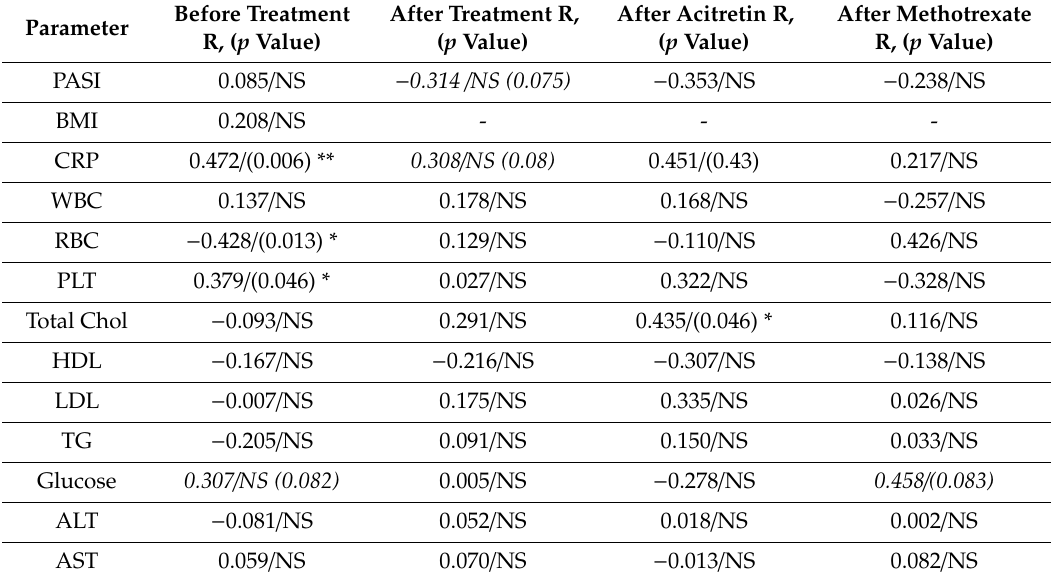
Table 3. Correlations between baseline parameters and SeP in sera of the study group before and after total treatment and both drugs separately. Parameter R, ( p